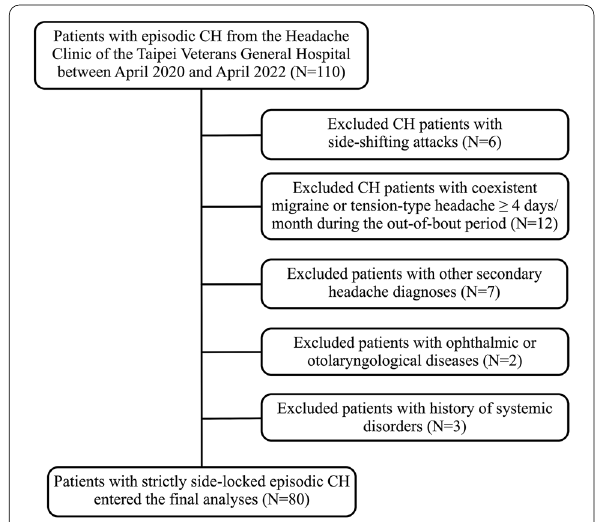
Fig. 1 Study schematic flow